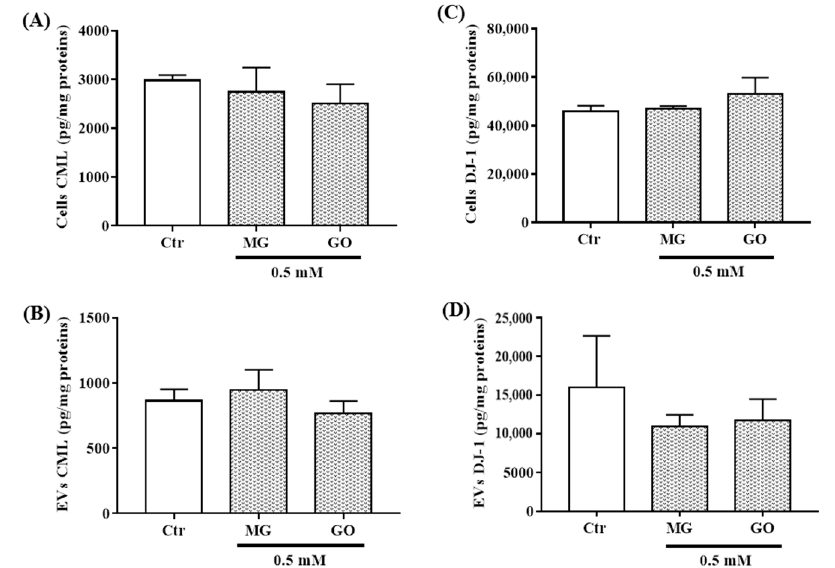
Figure 8. CML and DJ-1 levels in nEVs and in SK-N-SH cells exposed or not to MG and GO. The level of each marker is normalized using total protein concentration. The bar graphs show CML ( A,B) and DJ-1 levels ( C,D ) in SK-N-SH cells ( A,C ) and nEVs ( B,D ). Values are mean ± S.E.M (from three separate experiments) and data groups were compared with one-way ANOVA followed by the Dunnett’s post hoc test.